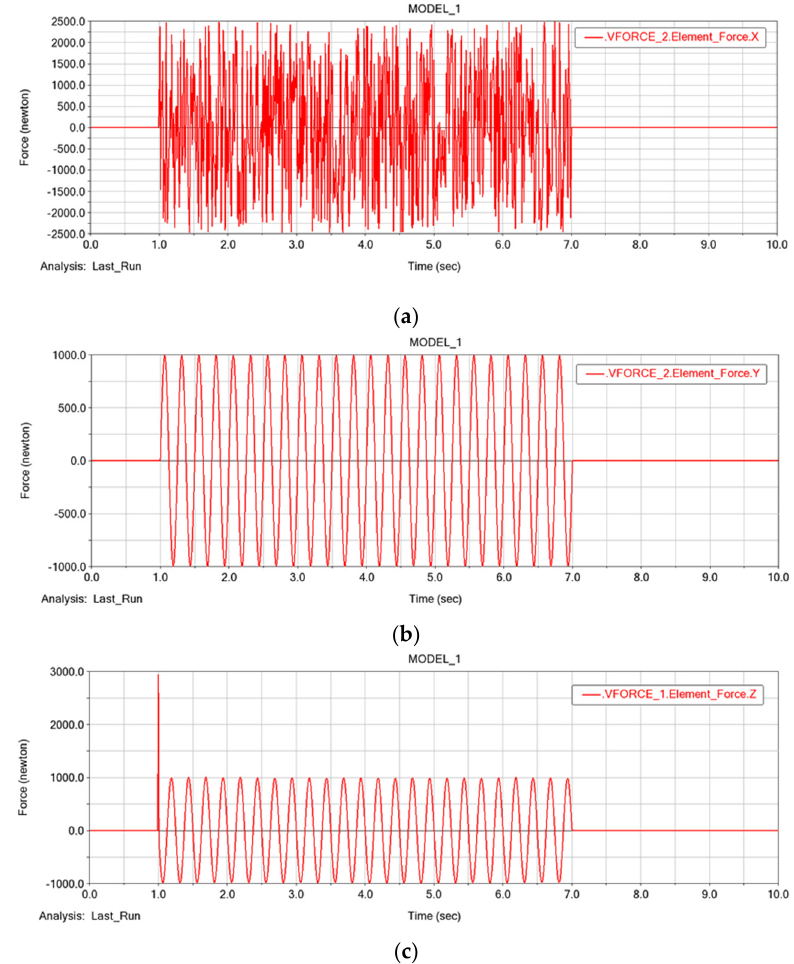
Figure 15. The disturbance force in X, Y, and Z axis: ( a ) the disturbance force in X axis; ( b ) the disturbance force in Y axis; ( c ) the disturbance force in Z axis.